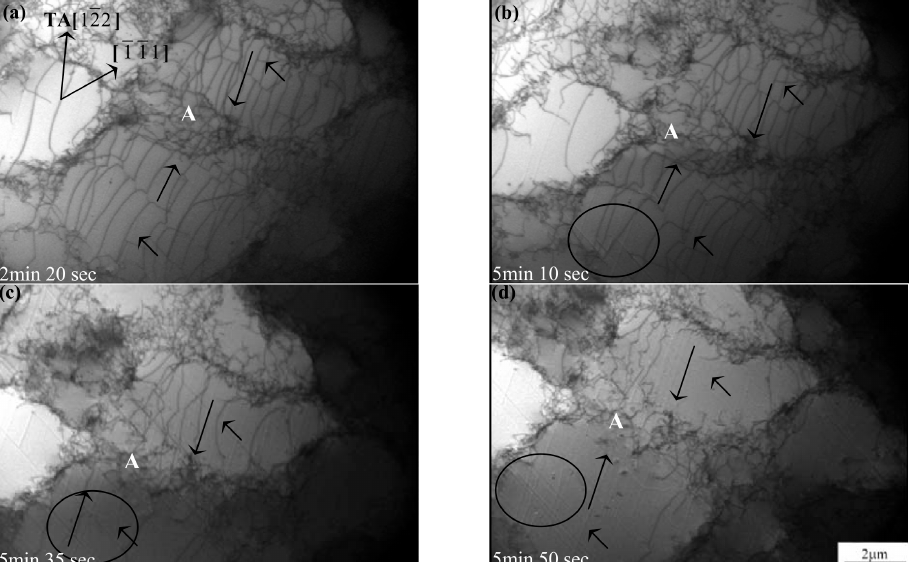
Figure 6. The in situ TEM observations of dislocation boundary evolution and the cross − slip of dis- location when single crystal aluminum was deformed to work hardening stage III [65], ( a ) − ( d ) frames at the time of 2 min 20 s, 5min 10 s, 5 min 35 s and 5 min 50 s, showing the depletion of the cell’s volume from dislocations into the cell’s boundary by cross slip of dislocation,